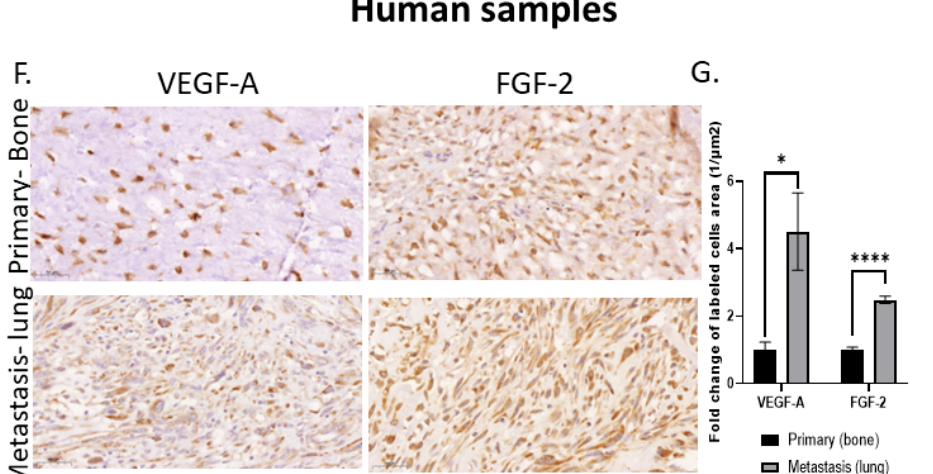
Figure 4. High VEGF-A and FGF2 labeling levels in an orthotopic OS mouse model and in human lung metastasis specimens: ( A ) U2-OS tumor image at 5 weeks and ( B ) anti-VEGF-A immunolabeling. Representative images of primary OS tumors in mice and nearby bone. The labeling pattern was mainly cytoplasmic; however, nuclear labeling was also noticed. Images were obtained under a × 40 magnification. Scale bar denotes 50 µ m. ( C ) Quantitative analysis of immunolabeled area (tumor/bone ratio) of primary OS tumors in mice normalized to nearby bone. Primary OS tumors exhibit significantly higher VEGF-A levels compared to control bone; *** p < 0.001. ( D ) FGF2 immunolabeling. Representative images of primary OS tumors in mice and nearby bone. Images were obtained under × 40 magnification. Scale bar denotes 50 µ m. ( E ) Quantitative analysis of immunolabeled area (tumor/bone ratio) of primary OS tumors in mice normalized to nearby bone. Primary OS tumors exhibit significantly higher FGF2 levels compared to control bone; ** p < 0.01. ( F ) Representative anti-VEGF-A and anti-FGF2 immunolabeling of human metastatic OS and non- metastatic OS patient specimens. Images showing nuclear labeling pattern. Microscope images were obtained under × 40 magnification. Scale bar denotes 50 µ m. ( G ) Quantitative analysis of immunolabeled area (1/ µ m 2 ) in metastatic vs. non-metastatic human OS specimens. Higher levels of VEGF-A (primary, N = 7; metastasis, N = 8) and FGF2 (primary, N = 6; metastasis, N = 14) were obtained in metastatic samples compared to primary tumors; * p < 0.05, and **** p <